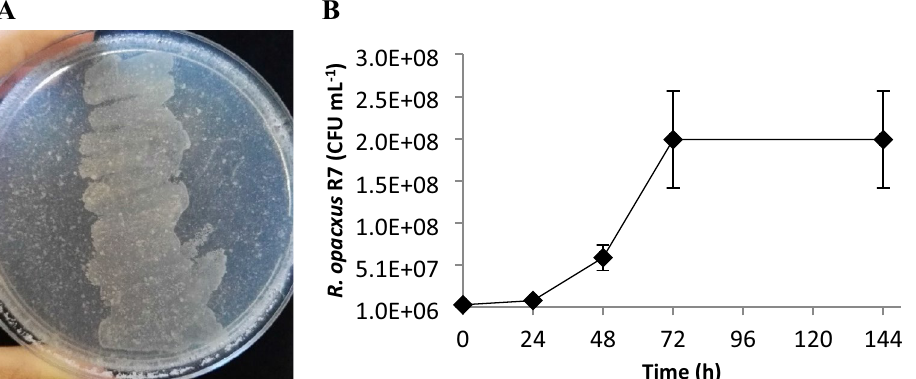
Figure 1. R . opacus R7 growth on polyethylene. ( A ) Shows preliminary growth assay performed inoculating R. opacus R7 on M9 mineral medium agar plates supplemented with 1.2% PE and 1% Tween80. ( B ) Shows R7 kinetic growth on M9 mineral medium supplemented with PE 1.2% as the only carbon and energy